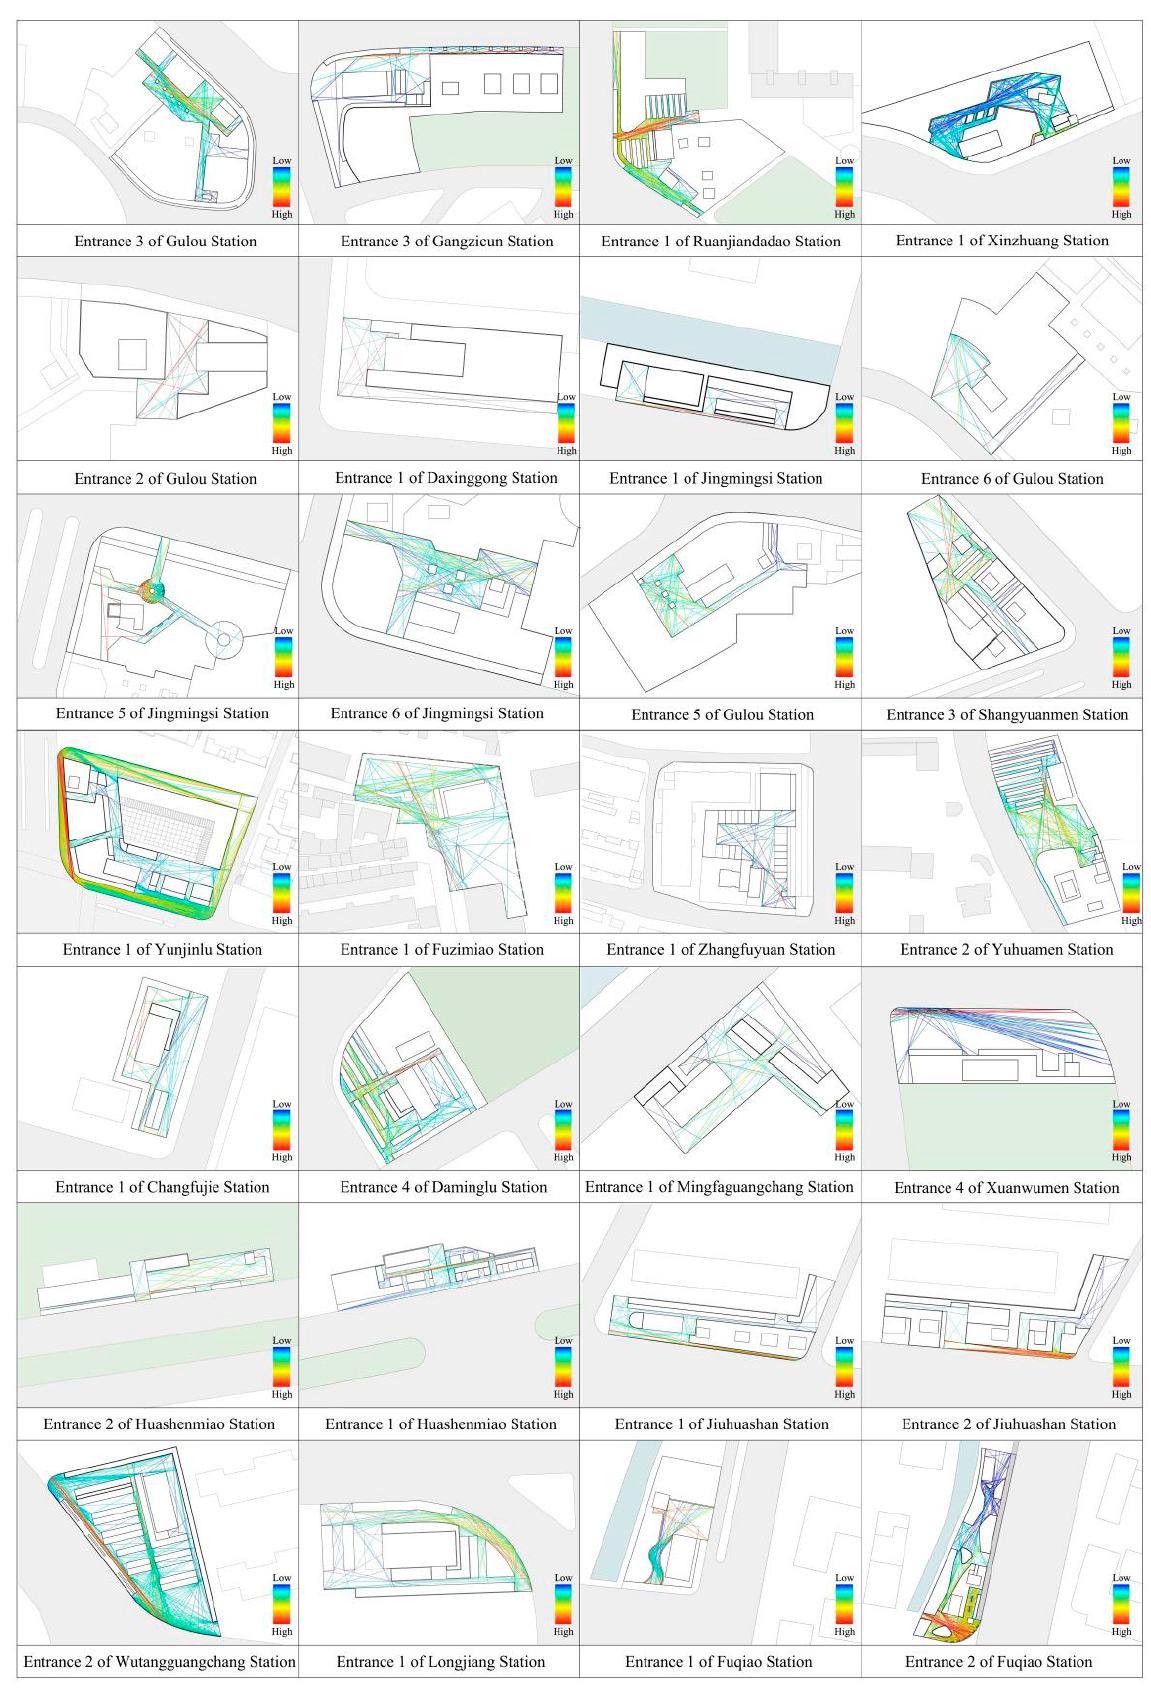
Figure 4. Examples of acquisition results of traffic